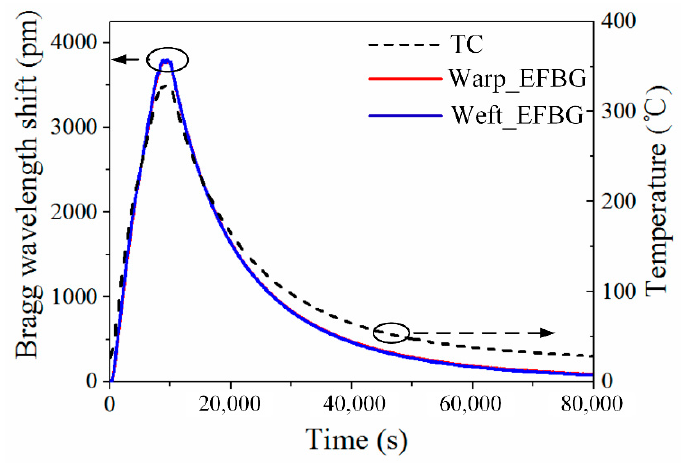
Figure 8. Raw data obtained from EFBGs and TC.